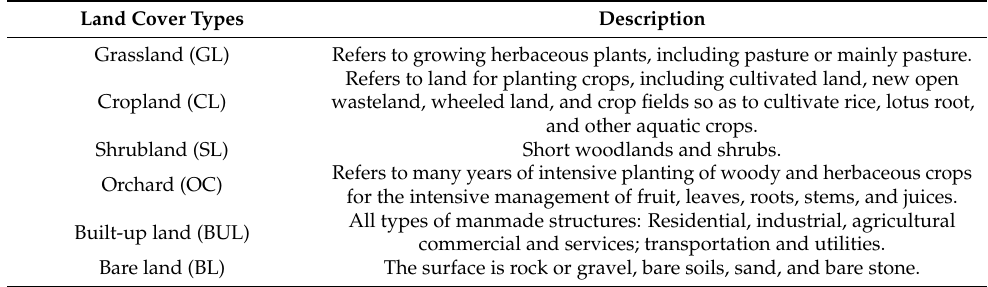
Table 1. Land use types in the study area (based on the Yi and Chinese National Standard) [32,33].